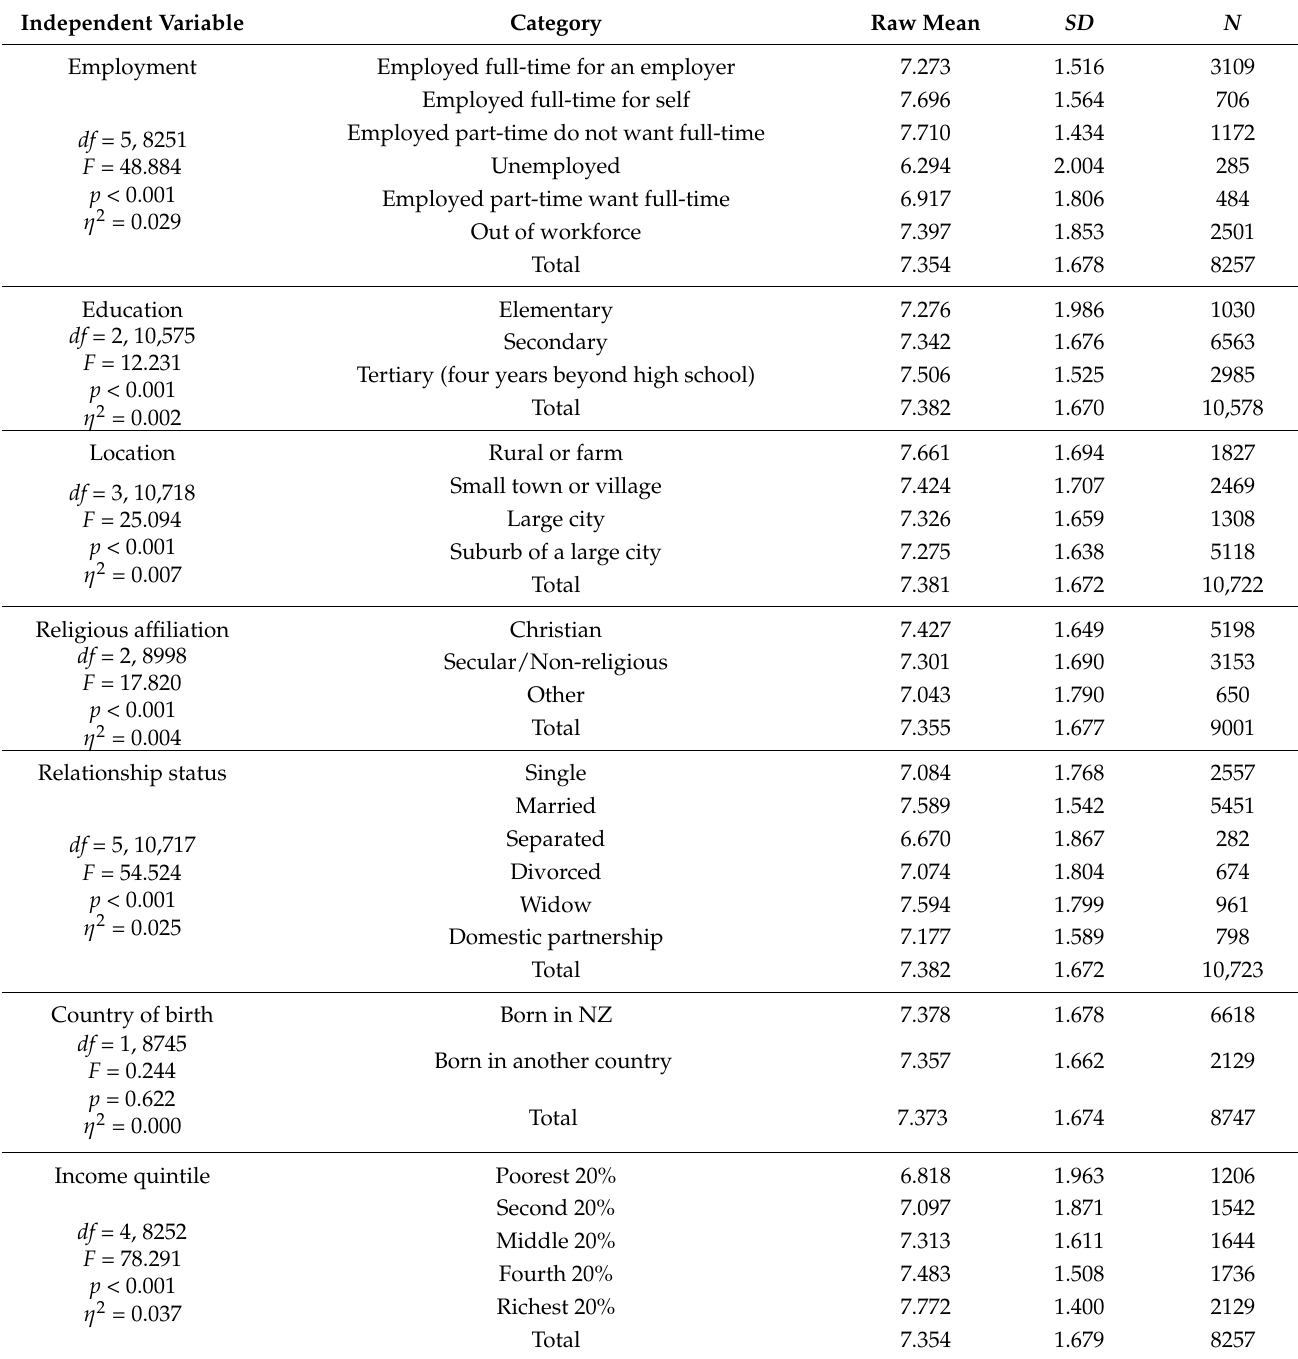
Table 1. ANOVA Results Predicting Life